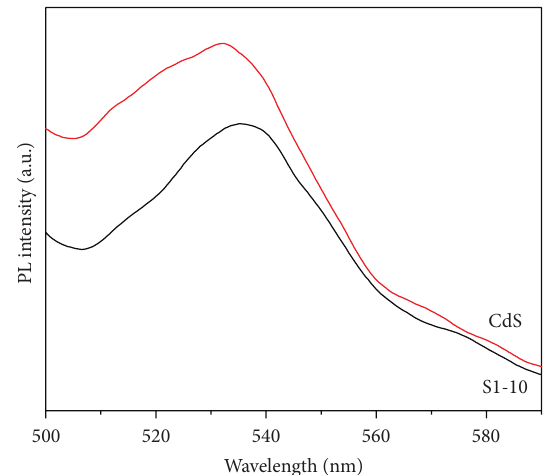
Figure 6: UV-vis diffuse reflectance spectra (DRS) of CdS, S1-10: 10wt% TiO 2 /CdS (10h), and TiO 2 , respectively.